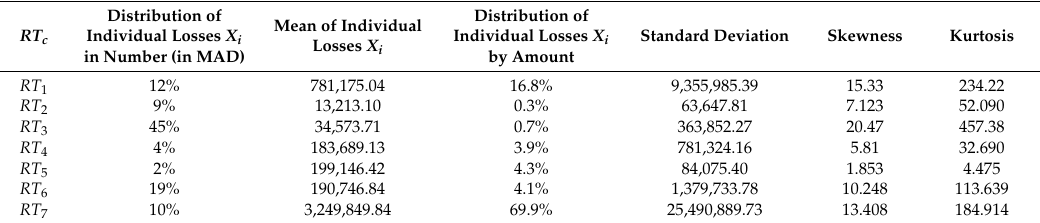
Table 4. Statistical characteristics of individual losses X i by risk category (in amounts).